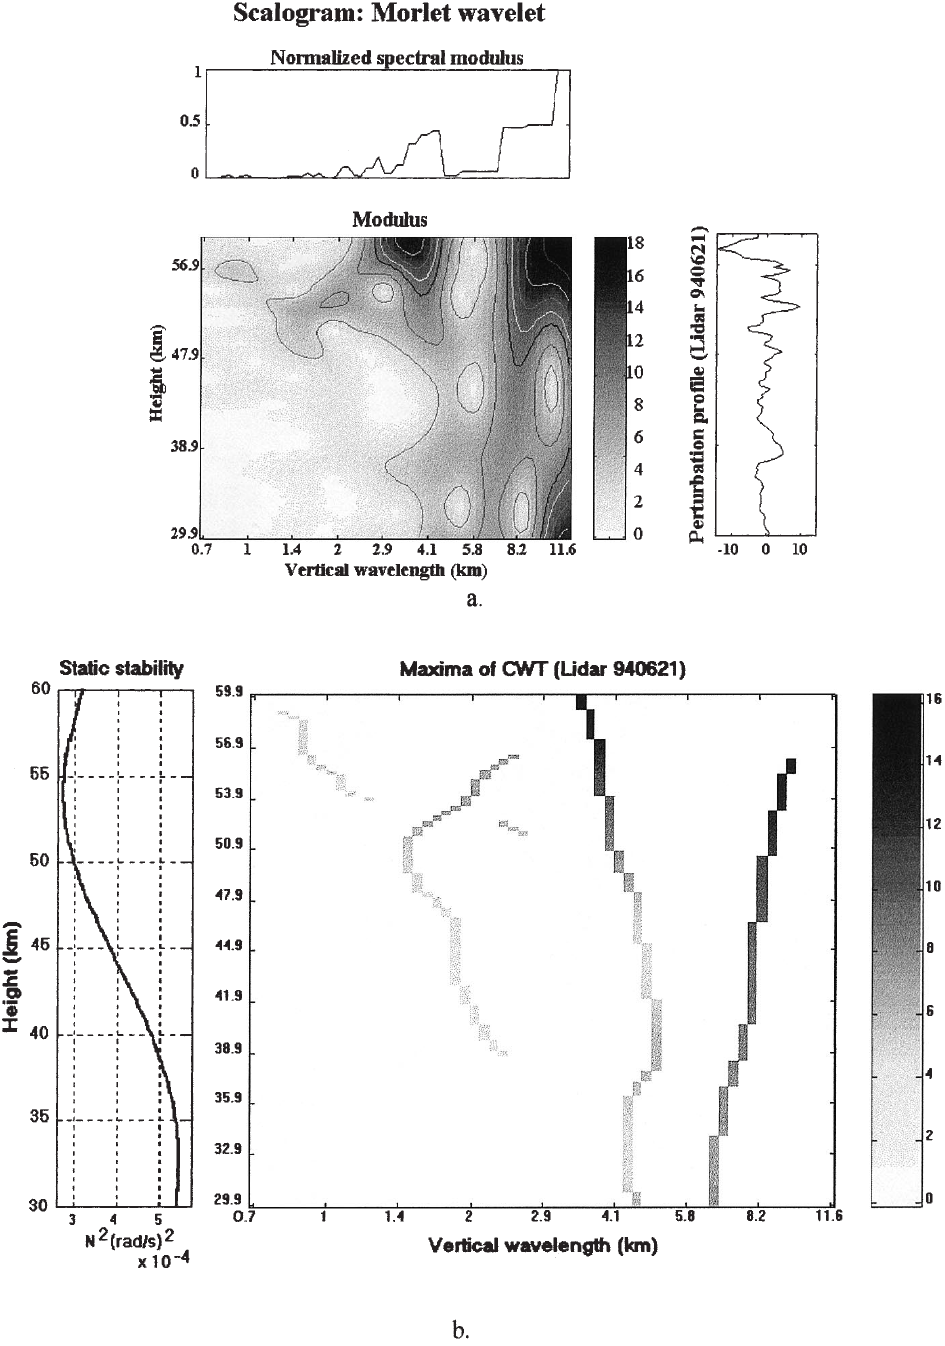
Fig. 3a, b. Averaged vertical temperature profiles over twelve 30-min integrated pro- files with a 300-m spatial reso- lution obtained from Rayleigh lidar measurements on June 21, 1994, between heights of 30 km and 60 km. a The CWT repre- sentation using the Morlet wavelet of the averaged vertical temperature perturbation pro- file ( right panel ). The normal- ized power spectral density with the standard FFT analysis is seen on the top panel . The CWT amplitude yields infor- mation on the spatial distribu- tion and the evolution of di(cid:128)erent events in the signal. b Skeleton of the CWT is extracted from the CWT amplitude. The static stability is plotted on the left panel . Three localized dominant qua- si-monochromatic structures are present with 1.5–2 km, 3.5– 5 km and 6.2–9.7 km